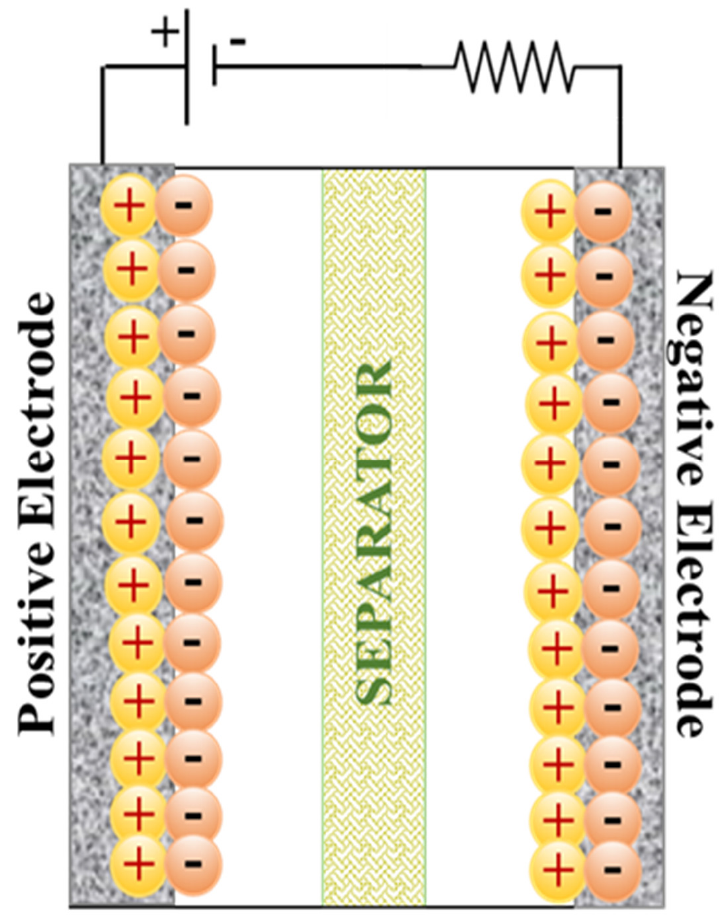
Figure 3. Illustration of EDLC scheme.